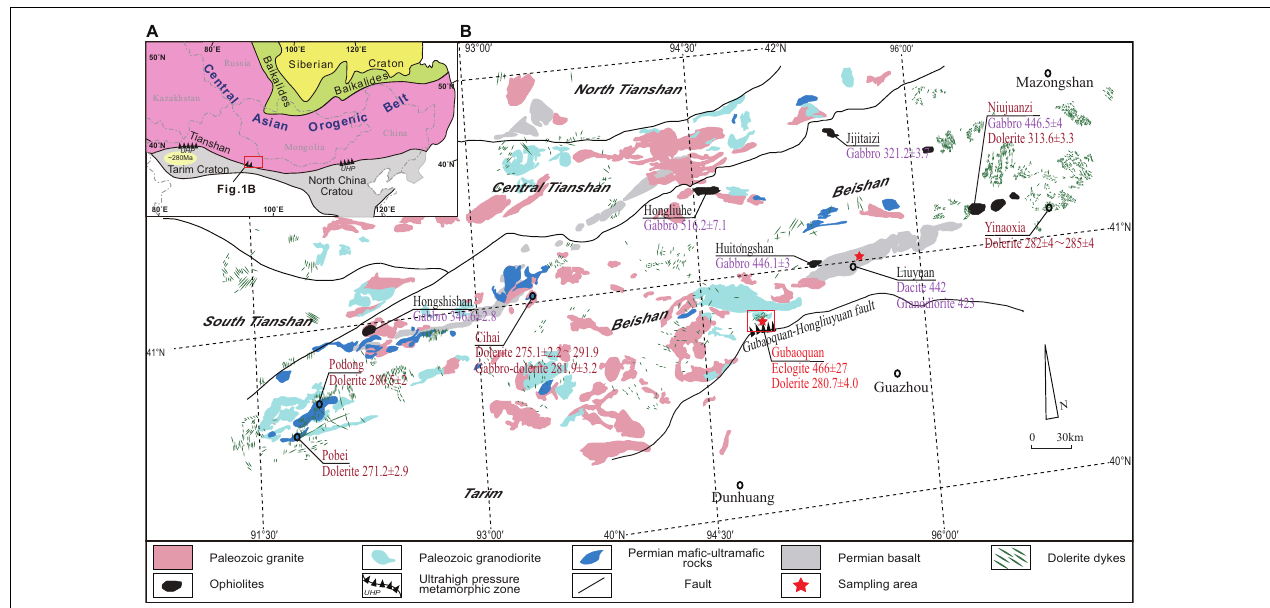
FIGURE 1 | (A) Simplified tectonic sketch map of the Central Asian Orogenic Belt (modified from Jahn, 2004). (B) Simplified geological map showing the distribution of Late Paleozoic dolerite dykes, mafic-ultramafic intrusions in the Beishan area modified from Xiao et al. (2004) and Xue et al. (2019). The age data (zircon U-Pb) from: Pobei dolerite (Tan, 2018), Podong dolerite (Xue et al., 2016), Hongshishan gabbro (Wang et al., 2014), Cihai dolerite (Chen et al., 2013, 2015), Cihai gabbro-dolerite (Chen et al., 2015), Hongliuhe gabbro (Zhang and Guo, 2008), Huitongshan gabbro (Yu et al., 2012), Jijitaizi gabbro (Li et al., 2012), Niujuanzi gabbro (Wu et al., 2012), Niujuanzi dolerite (Qi et al., 2017), Yinaoxia dolerite (Zhang et al., 2015; Peng et al., 2020), Liuyuan dacite (Mao et al., 2012), Liuyuan granodiorite (Zheng et al., 2018), and Gubaoquan eclogite (Saktura et al., 2017).